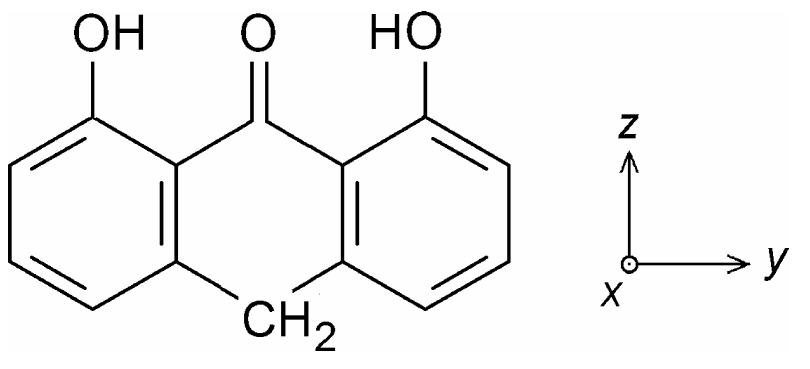
Figure 1 Anthralin (A) with definition of the molecular coordinate system. Full-size DOI: